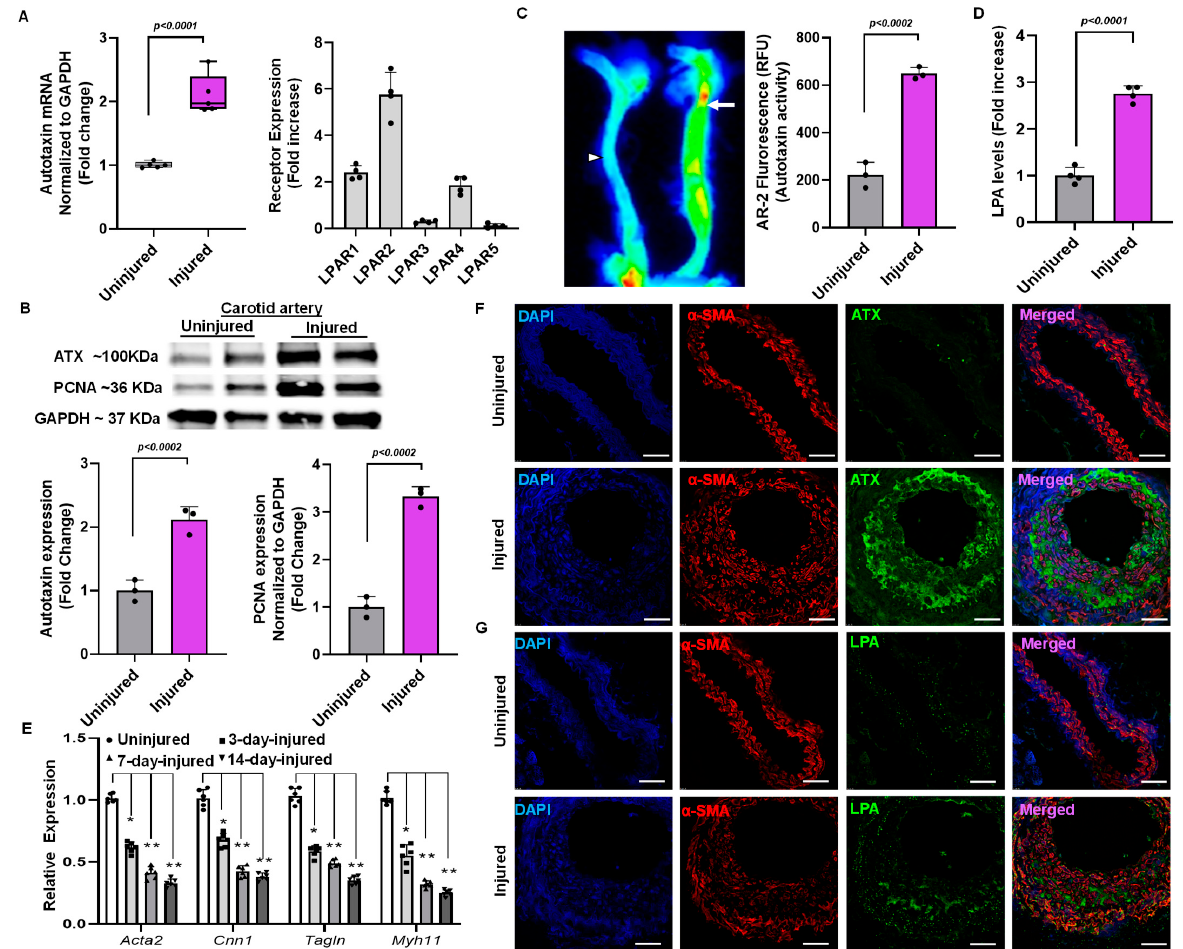
Figure 2. Vascular injury alters ATX expression in mouse carotid arteries. ( A ) ATX and LPA receptor mRNA expression was measured from the injured and uninjured arteries on day 14. ( B ) Immunoblotting for ATX and PCNA following 14 days of vascular injury. ( C ) The ATX enzymatic activity test was measured with AR2 fluorescence and quantified in terms of relative fluorescence units (RFUs) in uninjured and injured mouse carotid arteries. The arrow indicate the injured artery, and the arrowhead indicates the uninjured artery ( D ) The ELISA technique was used to measure LPA levels 14 days after vascular injury. All values are mean ± SD ( n = 3) compared to the uninjured vessel using the Mann–Whitney U test. ( E ) Quantitative polymerase chain reactions were used to measure the expression of the SMC differentiation markers Acta2 (SM-actin), Cnn1 (calponin), Tagln (SM22), and SD Myh11 (SM-myosin heavy chain) at different time points. The data were presented as the mean ± and analyzed using a one-way ANOVA followed by Tukey’s test for post hoc comparison. n = 6 for each group, * p < 0.05, and ** p < 0.001. ( F ) Immunohistochemistry for ATX and smooth muscle